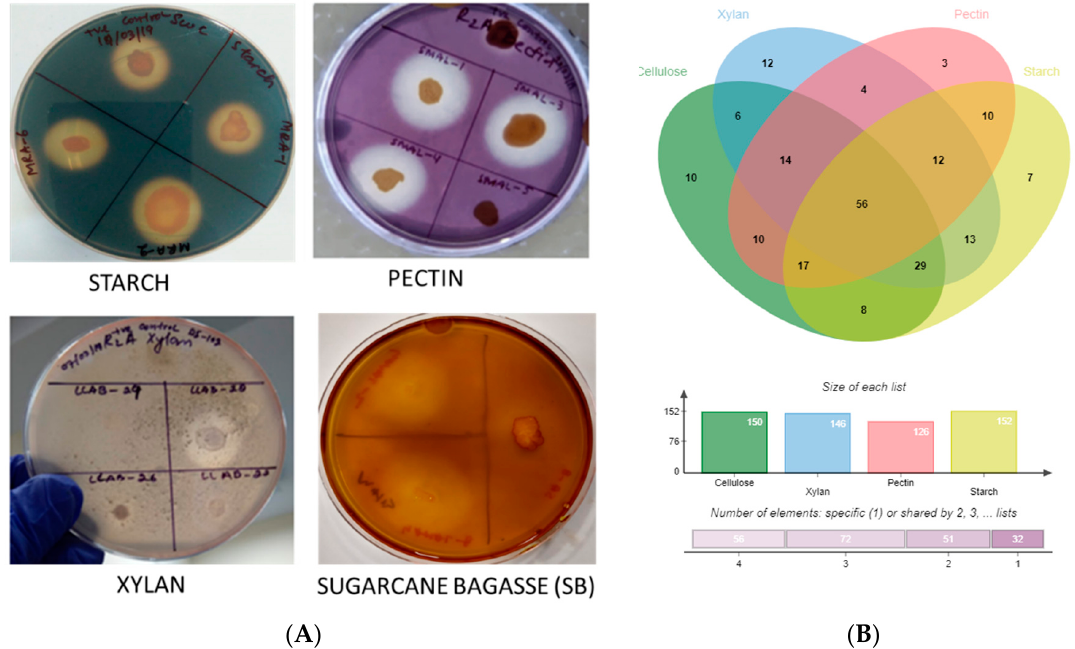
Figure 5. ( A ) Zone of clearance due to hydrolysis of polymer substrates, ( B ) Venn diagram revealing polymer degradation